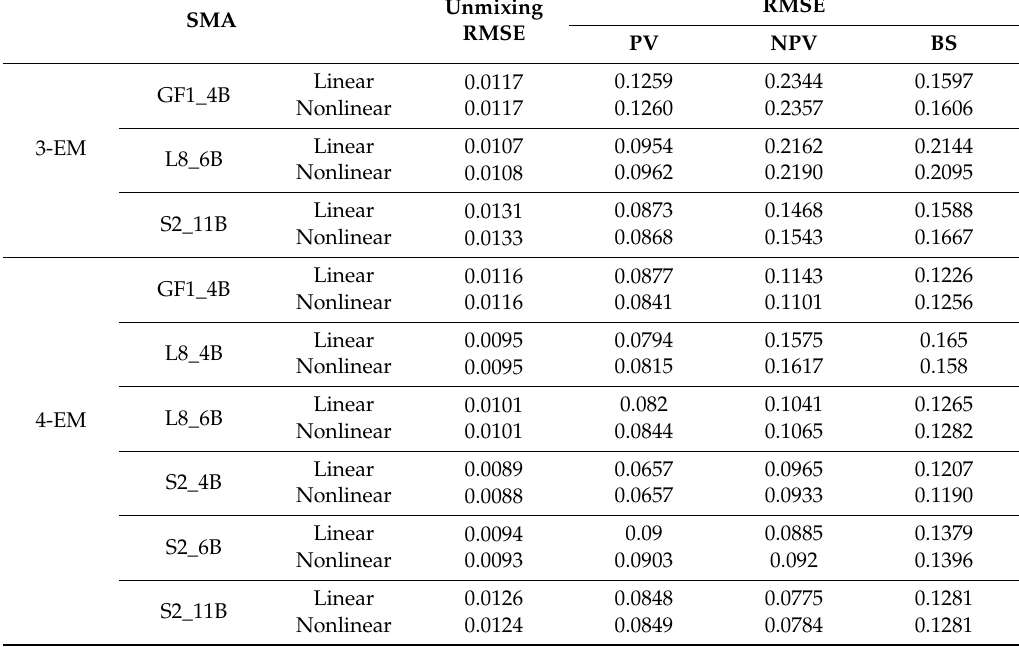
Table 2. 3-EM and 4-EM for unmixing based on three sensors and accuracy of each endmember-coverage estimation for sensors with di ff erent spatial resolutions and applied methods. GF1_4B